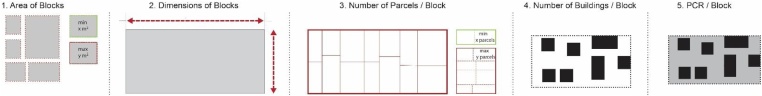
Different parameters that are used to measure the features of the block pattern.